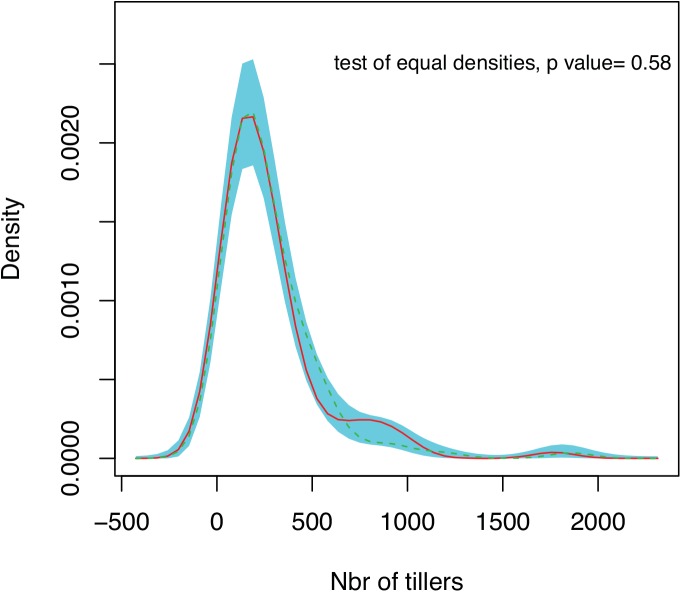
Size distribution of Festuca eskia plants at the Guzet site (France), as a function of the presence (red line) or absence (green line) of the fungal endophyte Epichloe festucae.CI±95% is in turquoise.